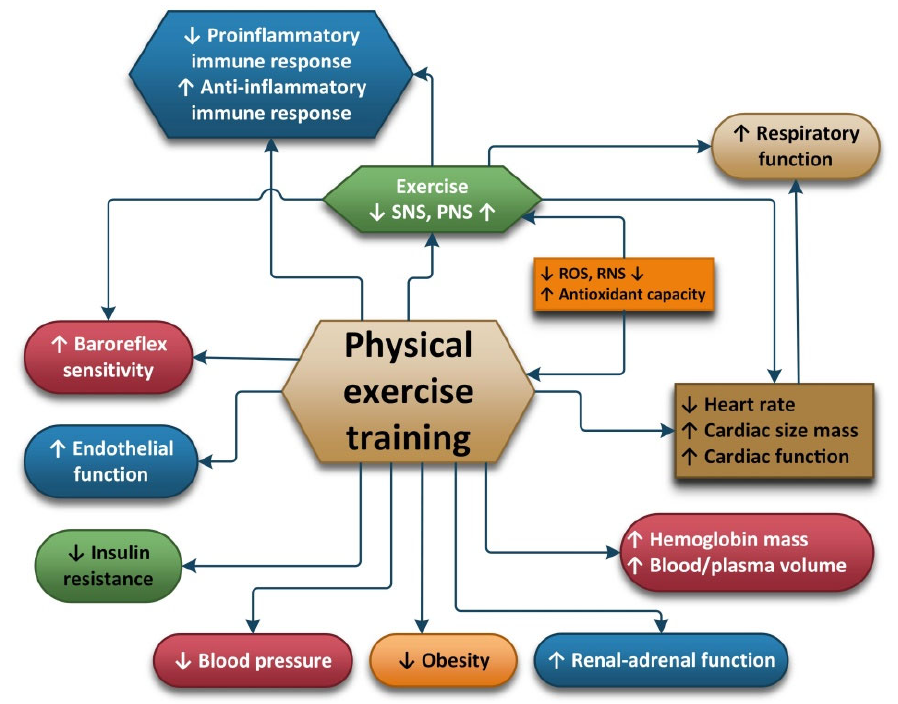
Figure 3. Pathophysiological changes under regular physical training.